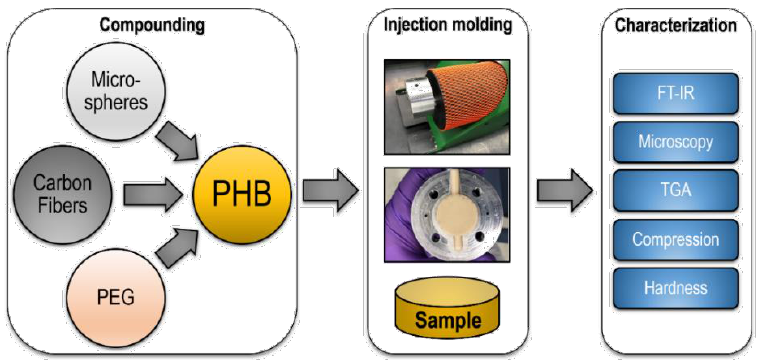
Figure 4. Sample process of preparing PHB based composites, through injection molding, to char- acterization.